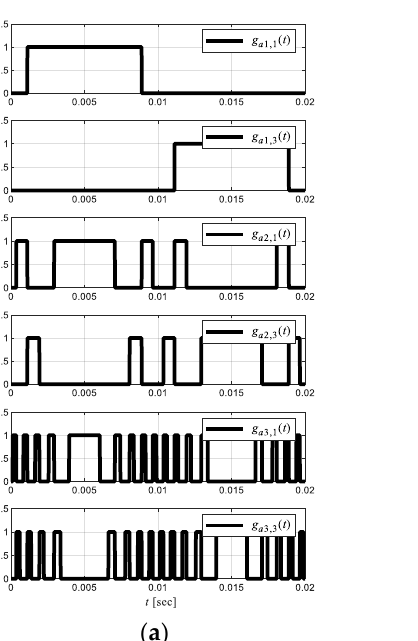
Figure 5. ( a ) Comparison THD output voltage, comparison between NLM and no regenerative modulation technique [22] ( b ) Switching frequency distribution by semiconductor device.